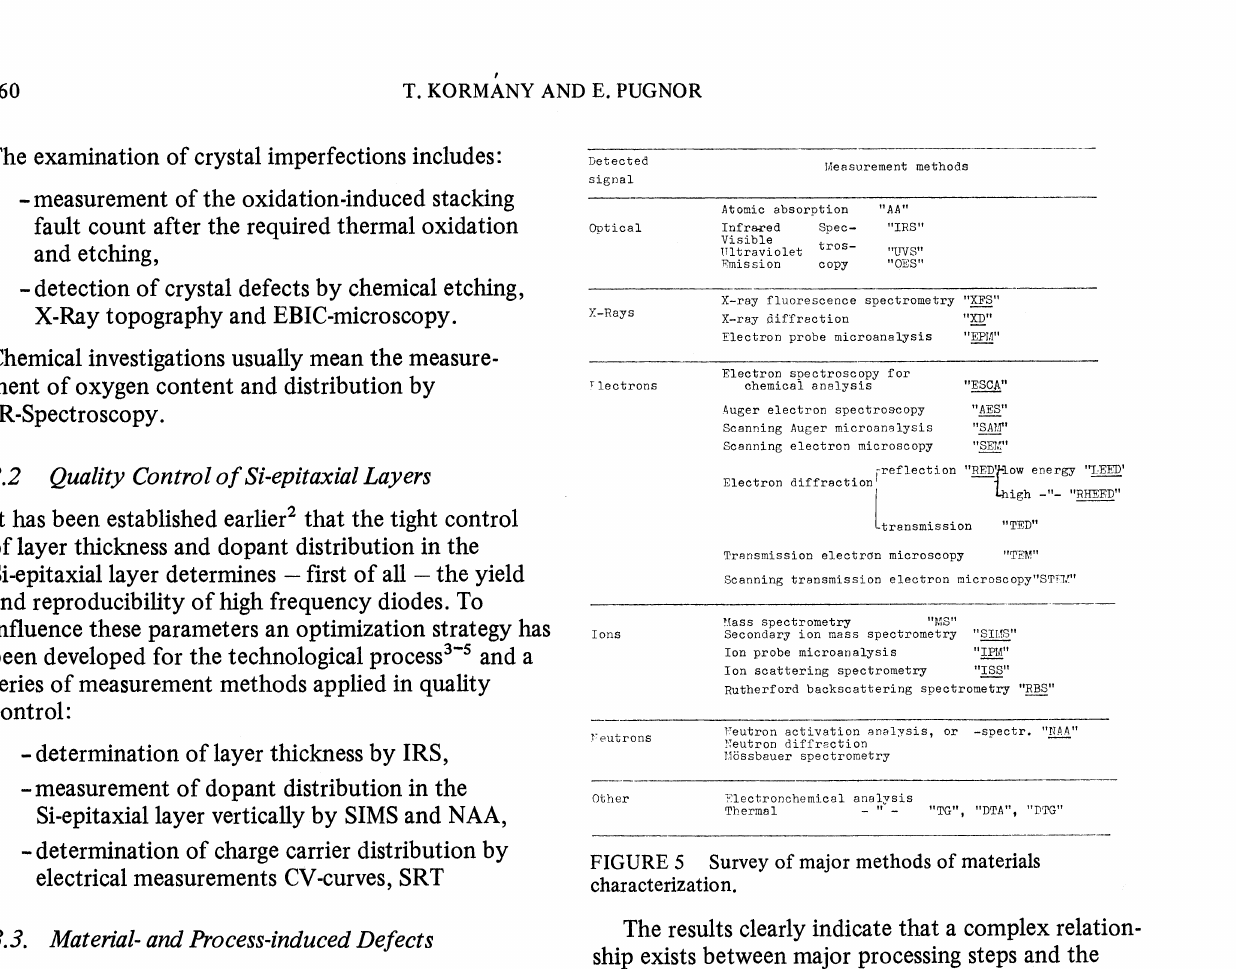
Survey of major methods of materials